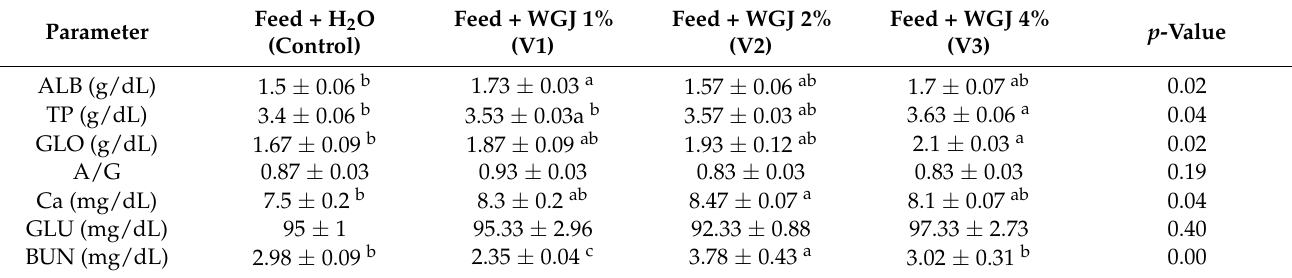
Table 6. Blood biochemical profile of common carp feed four experimental diets with different inclusion levels of wheat grass juice